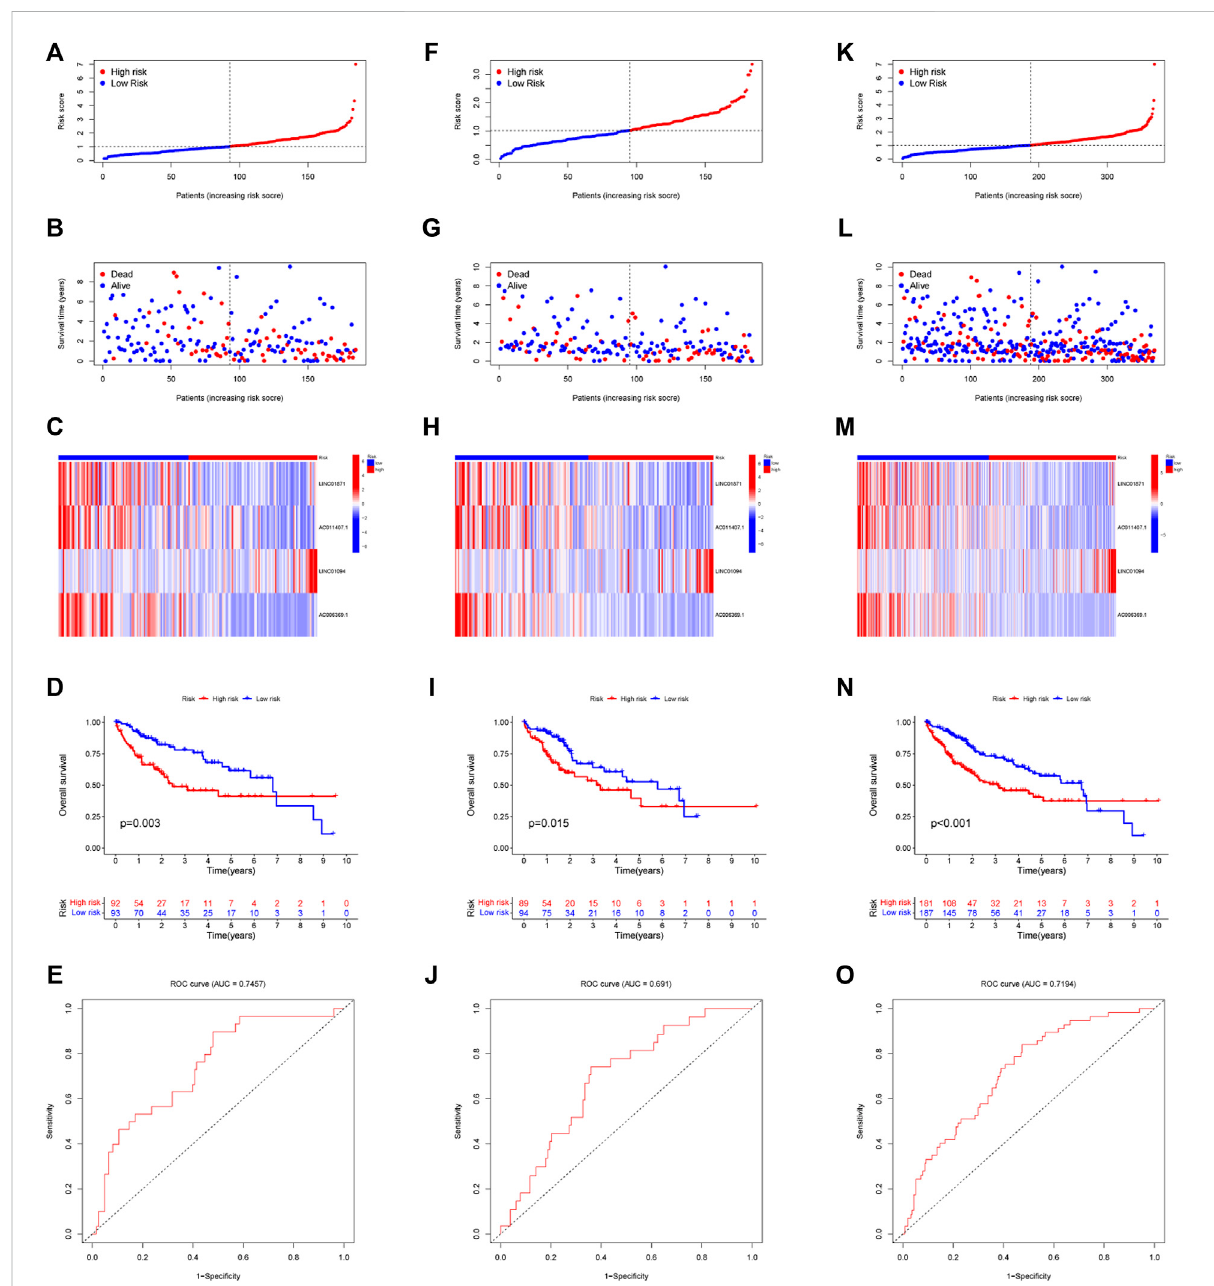
FIGURE 4 Modeling and verifying risk scores. (A) Distribution ofrisk scores amongpatients intraining cohort. (B) A scatterplot oftherelationship between OSandriskscoreofeachpersonintrainingcohort. (C) ExpressionoffourIIRLsintrainingcohortusingheatmap. (D) TheKMsurvivalcurveoftraining cohort. (E) The training cohort ’ s 1-year ROC curve ’ s area under the curve. (F) Distribution of risk scores among patients in testing cohort. (G) A scatterplot of the relationship between OS and risk score of each person in testing cohort. (H) Expression of four IIRLs in testing cohort using heatmap. (I) The KM survival curve of testing cohort. (J) The testing cohort ’ s 1-year ROC curve ’ s area under the curve. (K) Distribution of risk scores amongpatientsinentirecohort. (L) AscatterplotoftherelationshipbetweenOSandriskscoreofeachpersoninentirecohort. (M) Expressionoffour IIRLs in entire cohort using heatmap. (N) The KM survival curve of entire cohort. (O) The entire cohort ’ s 1-year ROC curve ’ s area under the